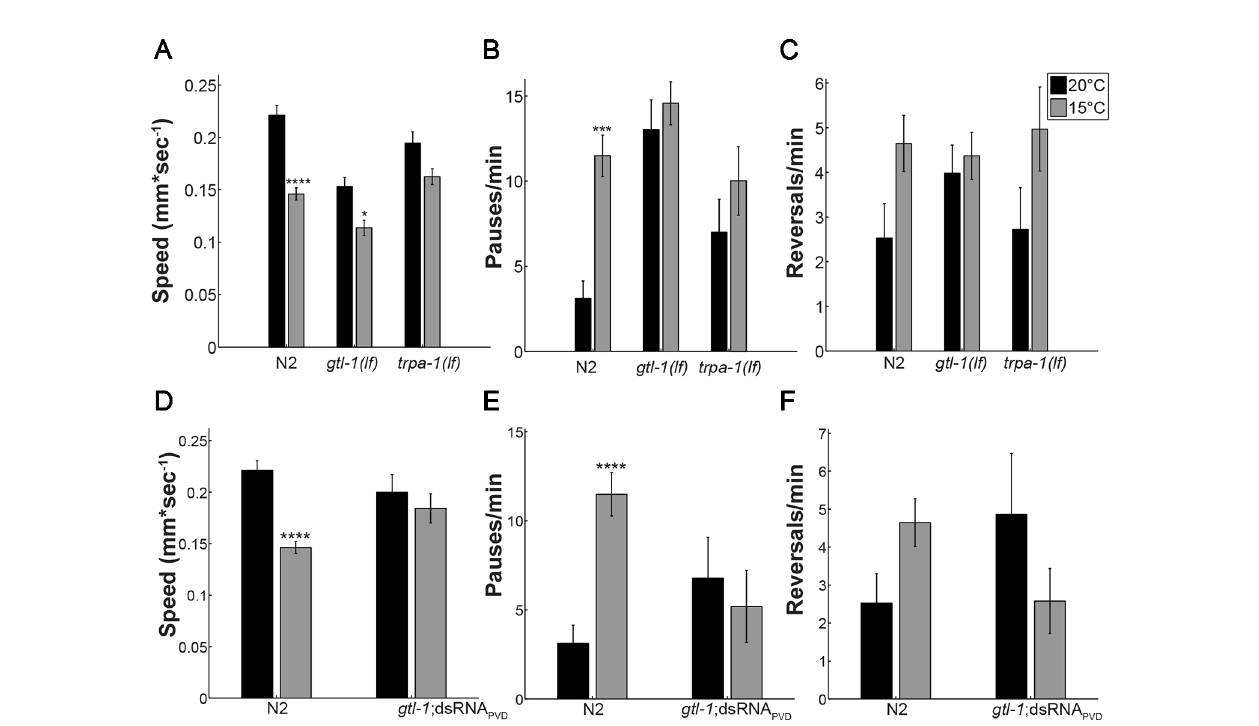
FIGURE 1 | GTL-1 is required within PVD for the effects of temperature on locomotion. Effects of temperature on locomotion were compared between wild type (N2), gtl-1(lf) , and trpa-1(lf) animals (A – C) and between wild-type (N2) animals and animals expressing gtl-1 dsRNA speci fi cally in PVD ( gtl-1; dsRNA PVD ) (D – F) , at 20° C (black bars) or 15°C (grey bars). Number of animals, 24, 36, 29, 22, 18, and 15 (A – C) and 24, 36, 13, and 12 (D – F) in order of appearance. Signi fi cant differences for the same strain at 15°C relative to 20°C were examined using two-way ANOVA with bonferroni ’ s multiple comparisons correction (*-p < 0.05, ***-p < 0.01, ****-p < 0.0001). Temperature contributes signi fi cantly to the variance in A (p < 0.0001), B (p = 0.0018), C (p = 0.0112), D (p < 0.0001) and E (p = 0.042); genotype contributes signi fi cantly to the variance only in B (p < 0.0001); and effects of the interaction are signi fi cant in A (p = 0.0069), B (p = 0.0476), D (p = 0.0069), E (p = 0.0032), and F